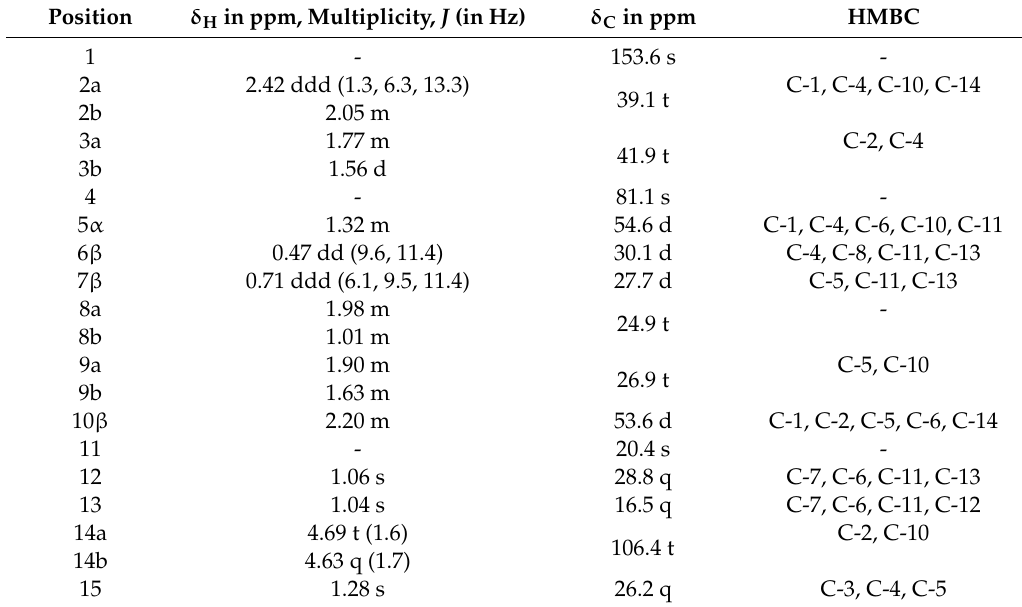
Table 3. 1 H (500 MHz), 13 C (125 MHz) and HMBC NMR data of compound 4 in CDCl 3 . Position δ H in ppm, Multiplicity, J (in Hz) δ C in ppm